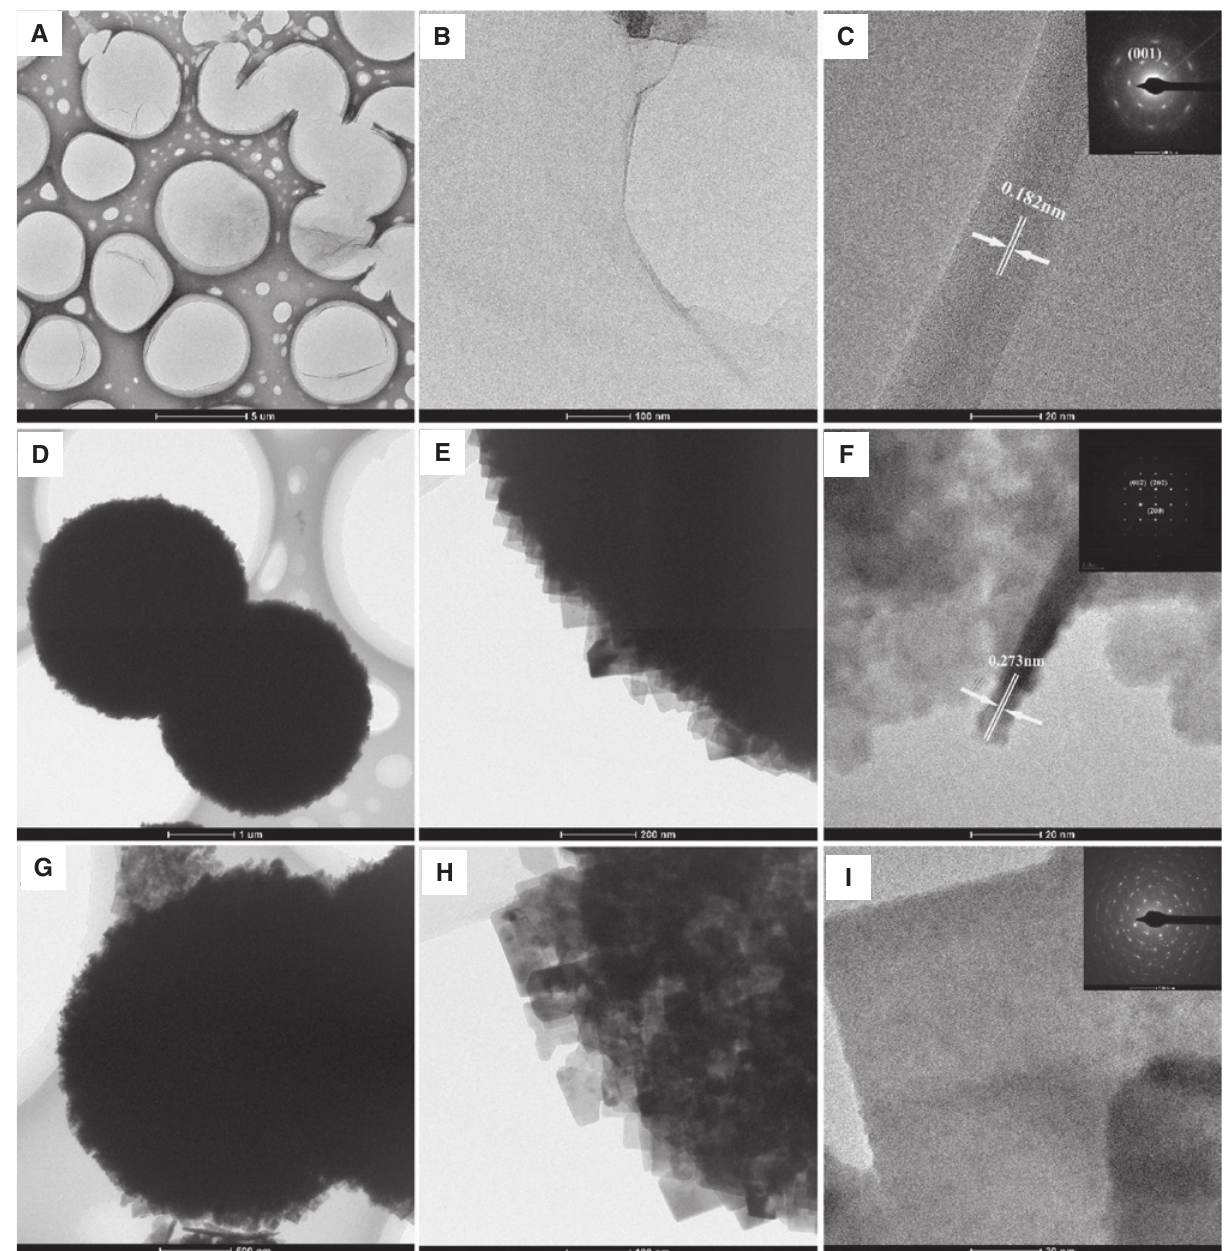
Figure 4: TEM images of the as-synthesized GO, BWO, 2% rGO-BWO samples: (A), (B) and (C) GO; (D), (E) and (F) BWO; (G), (H) and (I) 2% rGO-BWO (inset: SAED